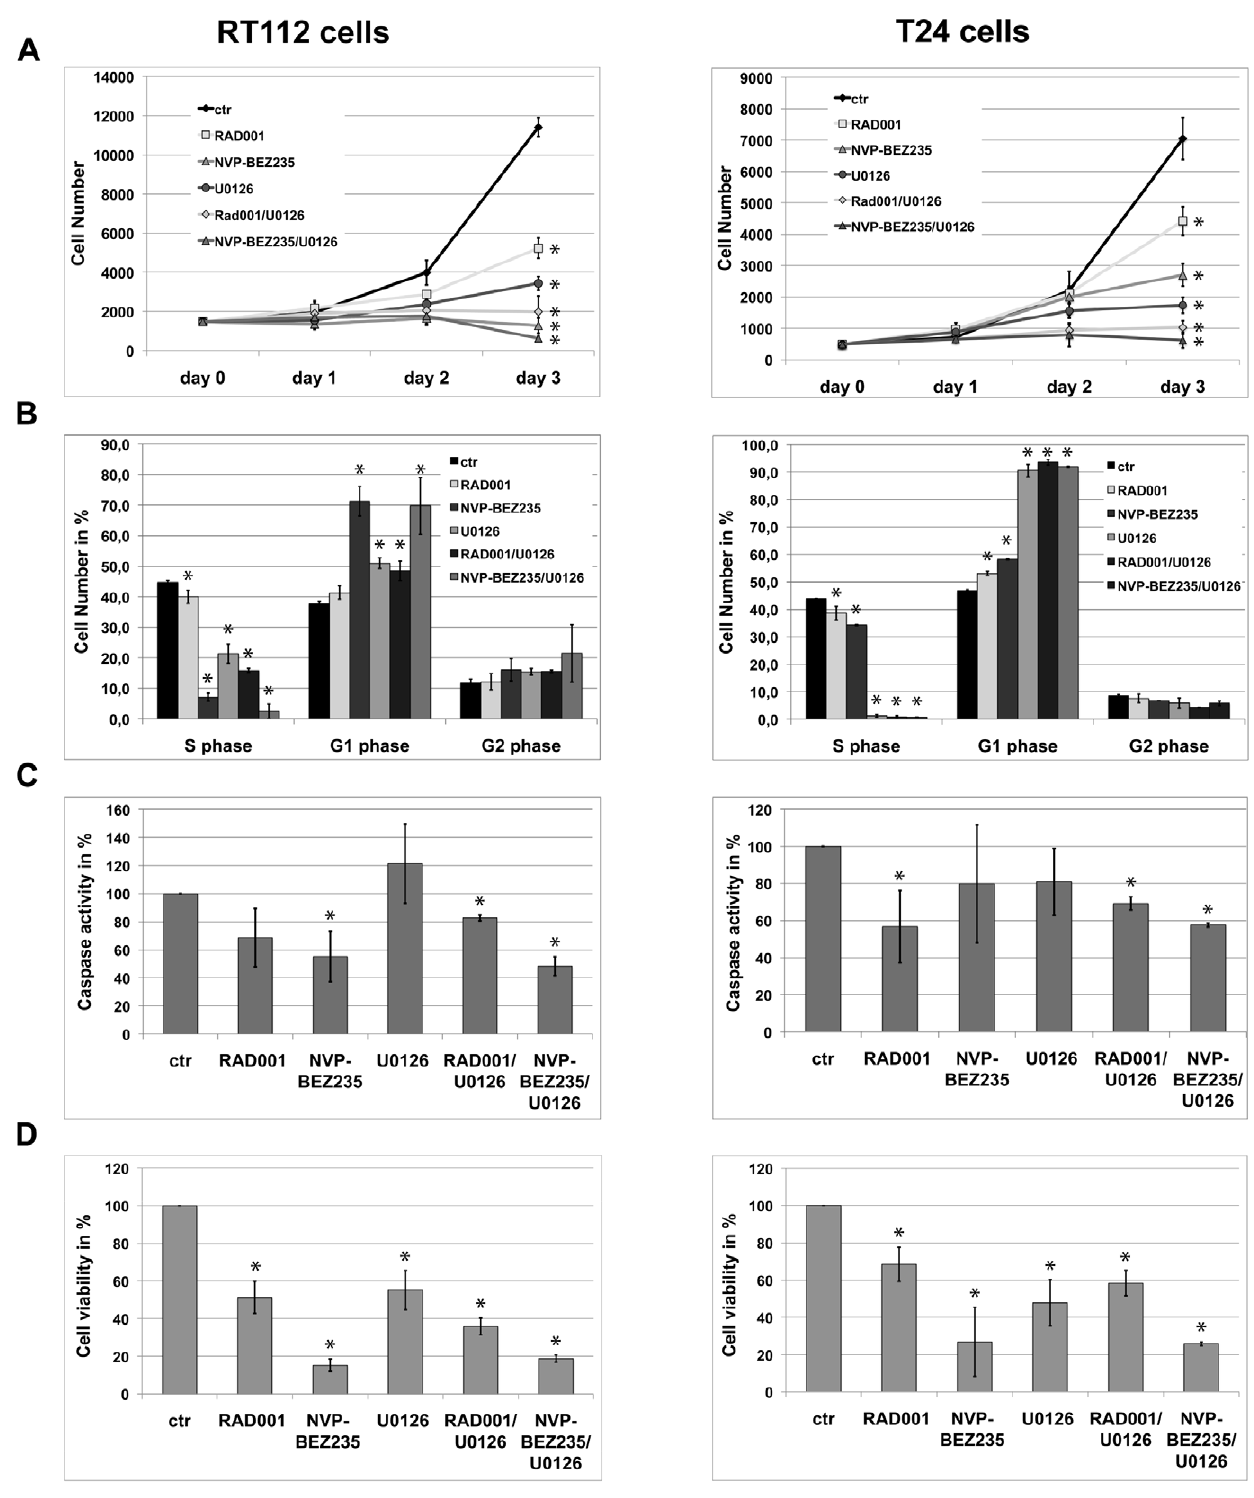
Figure 5. Effects of PI3K/Akt/mTOR and MAPK pathway inhibition on cell growth, proliferation, apoptosis and cell viability. RT112 and T24 cells were treated with RAD001 (5 nM), NVP-BEZ235 (100 nM for T24, 500 nM for RT112) and U0126 (25 nM) alone or the indicated combination and a DMSO control (ctr). A: For cell counts, cells were stained with trypan blue and numbers of living cells were determined. B: Cell cycle analysis after 24 h treatment with chemical compounds by BrdU incorporation in combination with 7-AAD staining. C: Measurement of caspase 3/7 activity as a parameter for apoptosis and D: XTT-test for detection of cell viability performed 24 h after treatment. Values shown are the mean 6 standard deviation from 3 independent experiments. Student t-test was performed for statistic analysis (*: p , 0,05).